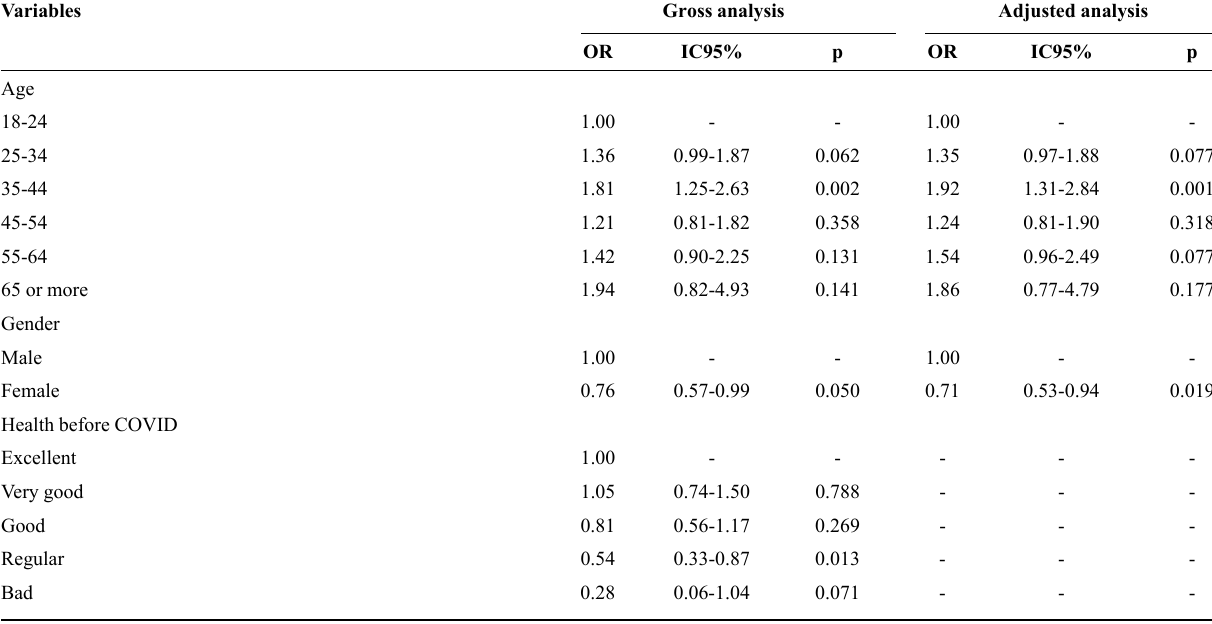
Table 3 - Factors associated with decreased physical activity (PA change) during social withdrawal (n = 1096) of residents of the city of Sao Paulo, SP, Brazil.